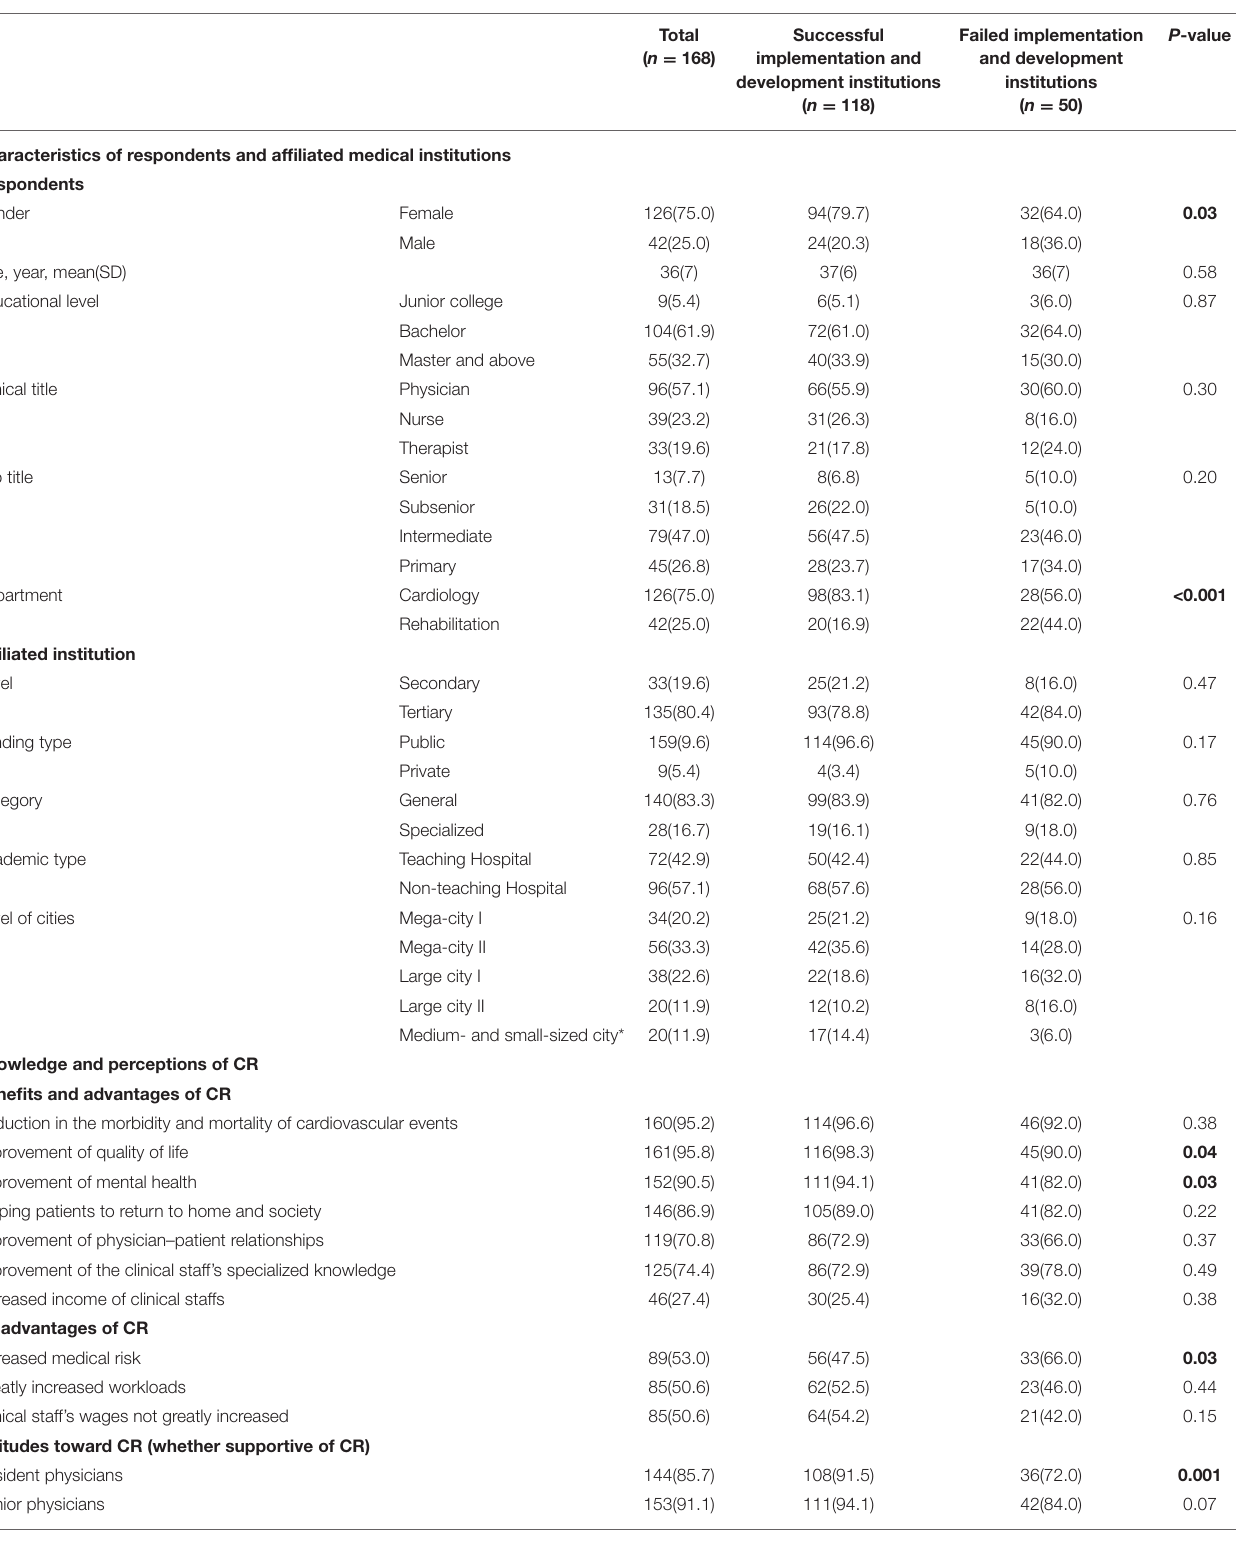
TABLE 1 | Factors associated with phase II CR implementation and